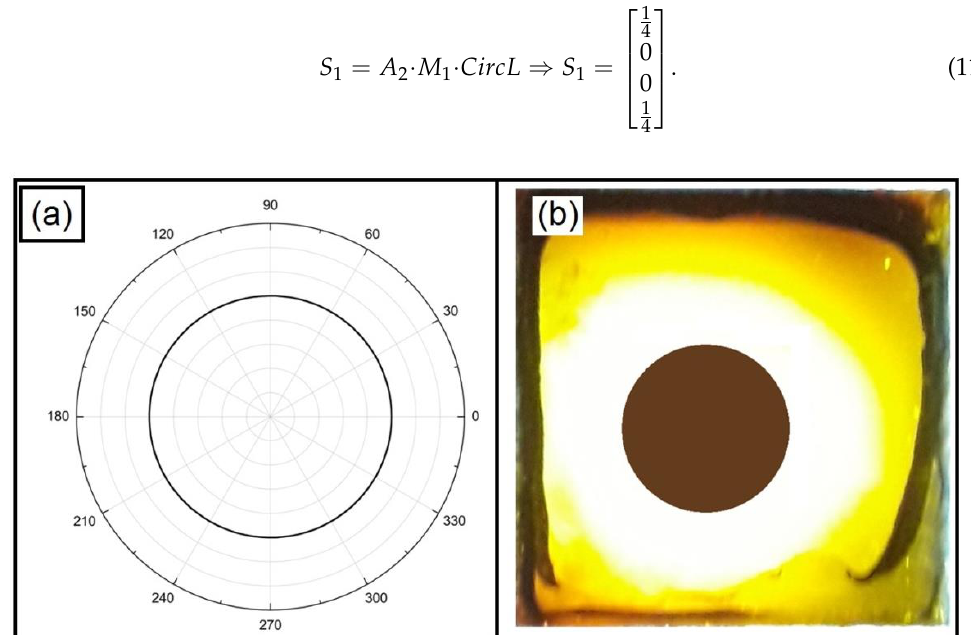
Figure 6. Polar plot for the Stokes vector intensity parameter S 1 in ( a ) of Equation (11). ( b ) Polarization image obtained with a Ferrocell for an incoming light circularly polarized to the left and analyzed with a circular polarizer to the right.